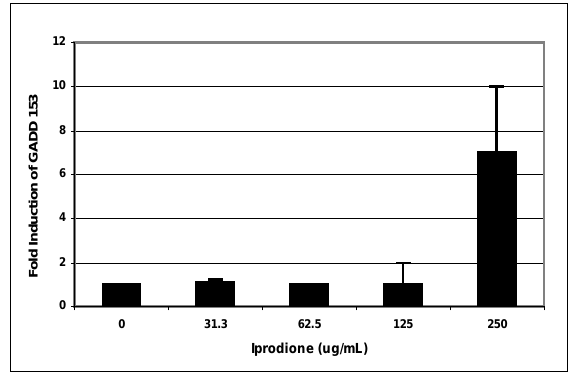
Fig. 9: Fold induction of GADD153 HepG cells 2 The activation of the 78-kDa glucose regulated protein (GRP78) shows a concentration dependent response to iprodione (Figure 10). The activation of this promoter indicates that iprodione has the potential to cause underglycosylation and stress conditions in the endoplasmic reticulum. GRP78 has also been known to respond to DNA damage.